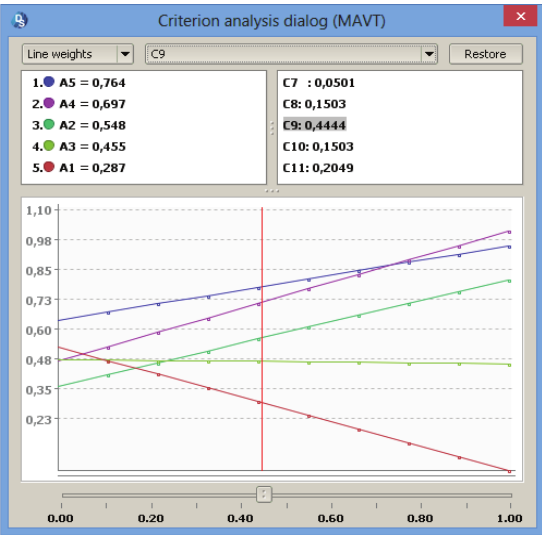
Fig.7. DecernsMCDA : MAVT ranking. Fig.8. DecernsMCDA : weight sensitivity